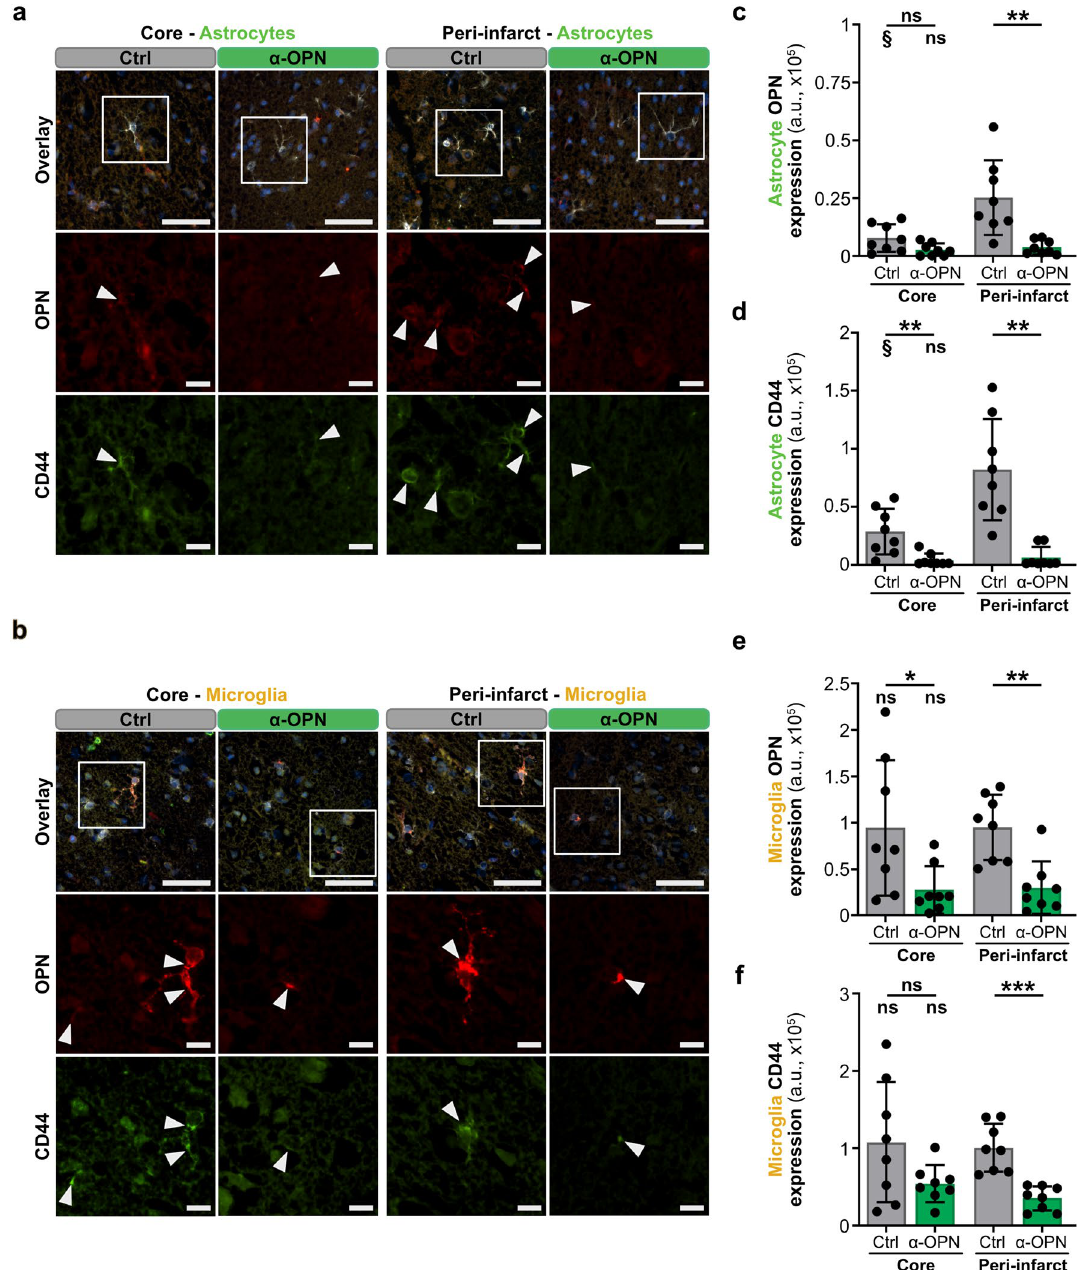
Figure 4. Anti-osteopontin antibody treatment reduces osteopontin and CD44 receptor expression in astrocytes and microglia post-ischemic stroke. ( a , b ) Representative images of immunofluorescence staining for osteopontin (OPN, red, inset), CD44 receptor (green, inset) and cell-specific markers (white, overlay) including GFAP for astrocytes ( a ) and IBA1 for microglia/macrophages ( b ) in the infarct core and peri-infarct region of Ctrl IgG and α-OPN antibody-treated mice 24 h post-ischemic stroke. White arrowheads indicate osteopontin and CD44 receptor expression in astrocytes and microglia/macrophages. ( c – f ) Quantification of osteopontin and CD44 receptor expression intensity (arbitrary unit, a.u.) in astrocytes ( c , d ) and microglia/macrophages ( e , f ) in the infarct core and peri-infarct region utilizing 3 images/region/animal, n = 8 and 8 for Ctrl IgG and α-OPN antibody treatment group, respectively; */ § P < 0.05, **P < 0.01, ***P < 0.001 and not significant (ns) P > 0.05. * indicates two-tailed, unpaired t-test with Welch’s correction when variances were significantly different based on F-test, comparing the two treatment groups for the same region, and § indicates two-tailed, paired t-test comparison of infarct core to peri-infarct region within the same treatment group. Scale bars 50 µm and 10 µm in insets ( a , b